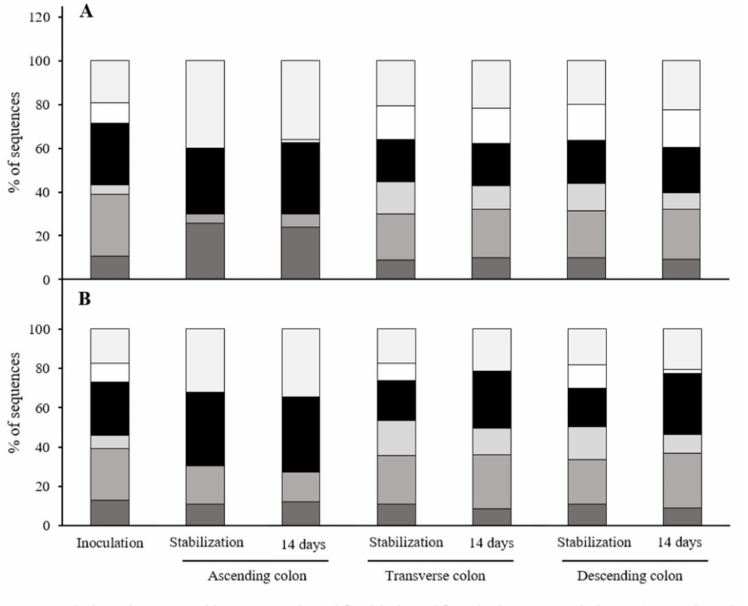
Figure 3. Relative presence (% of sequences identified) of the six most abundant phyla in the human colon in the dynamic in vitro gastrointestinal digestion and colonic fermentation model when fed with ( A ) free red cabbage aqueous extract, and ( B ) nanoencapsulated red cabbage aqueous extract. Data were obtained from the stabilization period (no treatment) and after 14 days of treatment. Represented data are means ± SD. Different letters mean statistically significant differences in the HSD Tukey’s test ( p < 0.05).